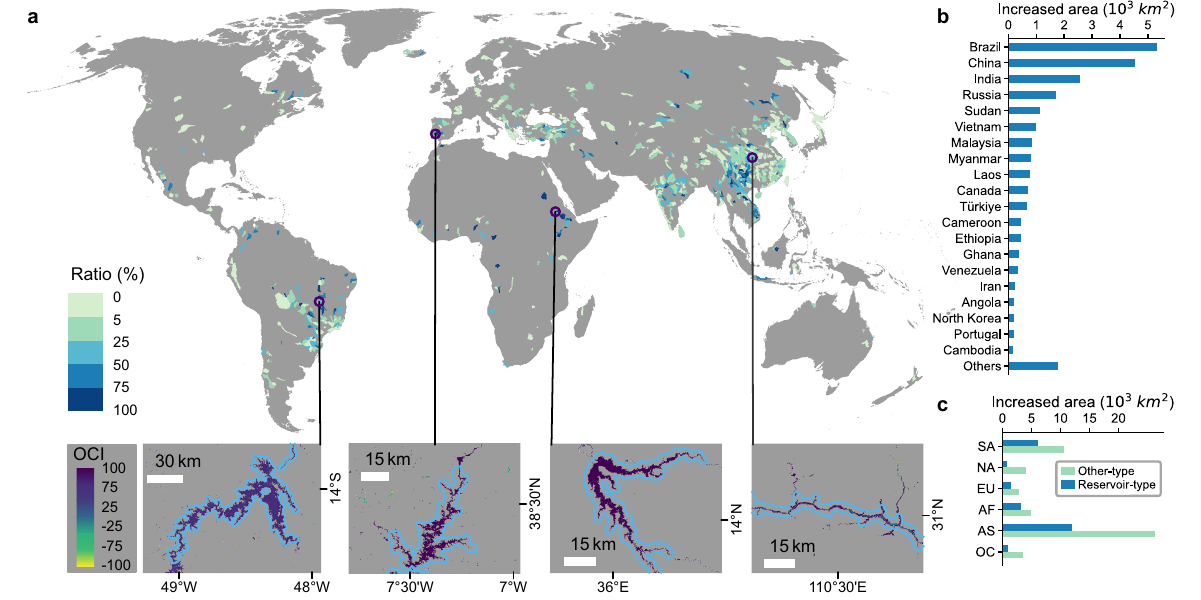
Fig. 2 | River widening caused by new dams (Type-R). a The ratio of expanded water extent (areas of signi fi cantly increased inundation frequency) to the basin- wide total river area reveals dam-related river widening across speci fi c regions of the world. The bottom insets (from left to right) are four typical giant dams of the world, the Serra de Mesa Dam (Brazil), the Alqueva Dam (Portugal), the Upper